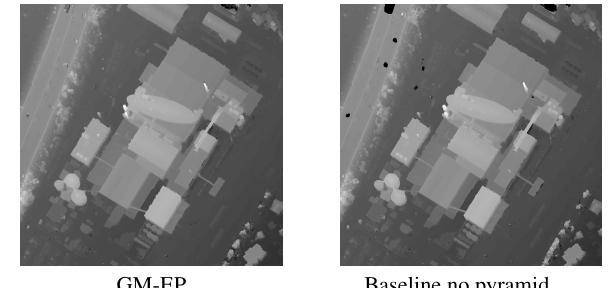
Figure 9: Final disparity maps. Black values represents dispari- ties of -15 pixels or below. White values represents disparities of 35 pixels or above.